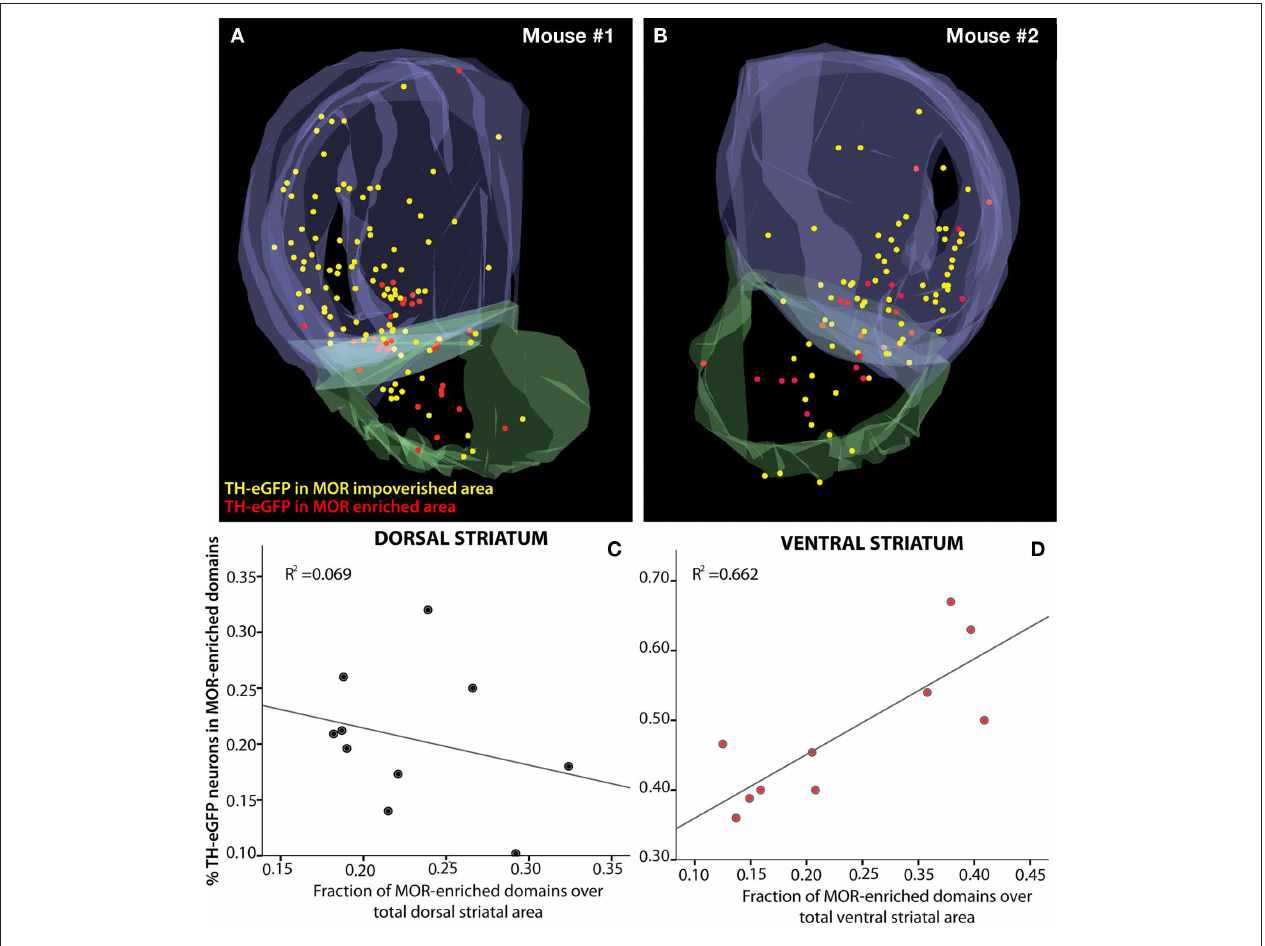
striatum. The plots depict the percent distribution of TH-eGFP neurons in MOR-enriched domains of dorsal and ventral striatum (C,D) . The relationship between striatal MOR-enriched domains and distribution of TH-eGFP neurons with respect to these domains is significantly different in dorsal (C) and ventral (D) divisions of the striatum ( p = 0.001). Note the differences in the scale of y -axes in